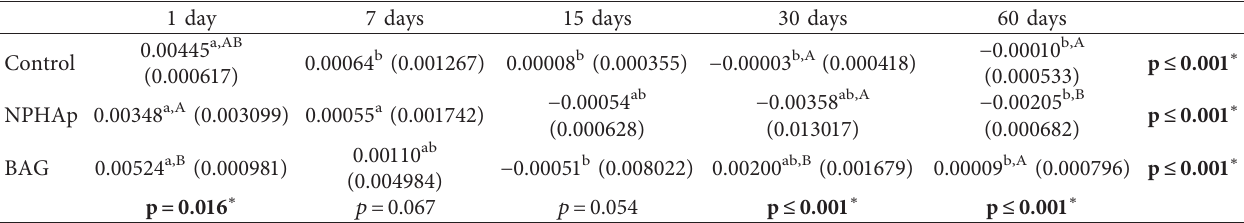
Table 1: Mass variation (g) over time (days)-mean of mass lost after brushing (standard deviation).